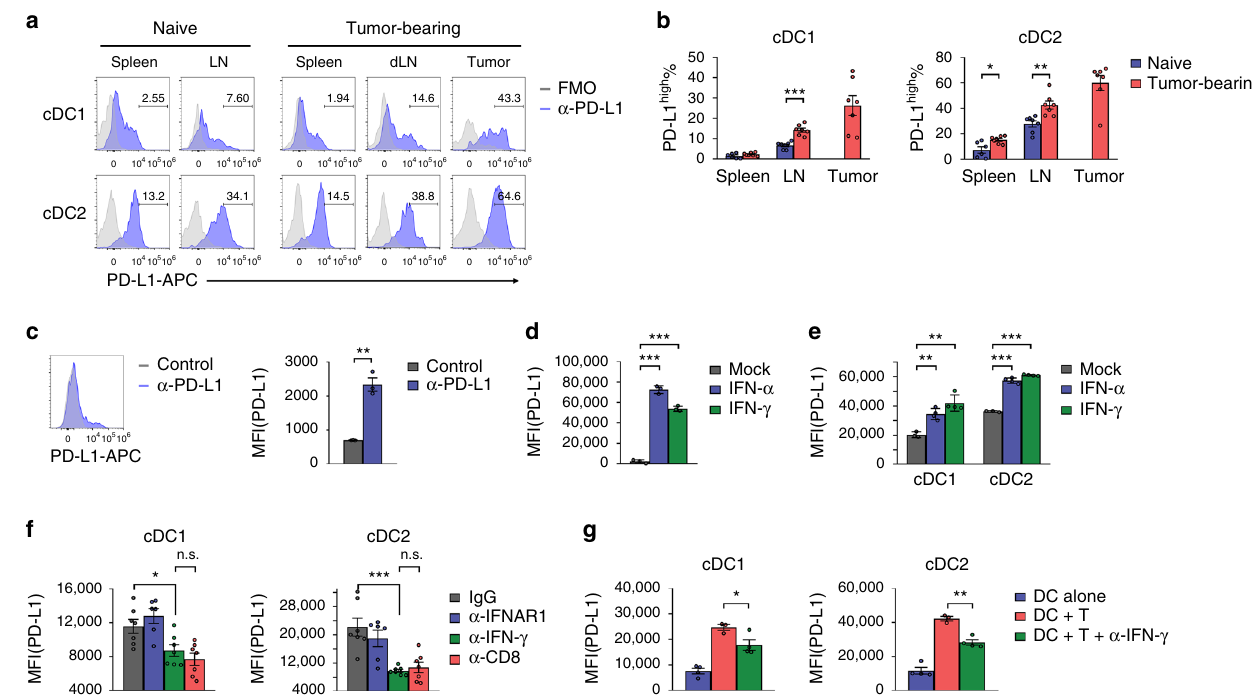
Fig. 3 PD-L1 on DCs is upregulated by IFN- γ and T cells in tumor microenvironment. a , b In naïve or MC38 tumor-bearing WT mice, PD-L1 levels on cDC1 (CD11b − CD24 + ) and cDC2 (CD11b + CD24 − ) were measured by fl ow cytometry ( n = 7, except naïve spleen n = 6). *** p < 0.0001; * p = 0.0106; ** p = 0.0030. c BMDCs were generated by FLT3-L. PD-L1 levels were measured by fl ow cytometry ( n = 3). ** p = 0.0010. d BMDCs were treated with recombinant IFN- α or IFN- γ . PD-L1 levels were measured 24 h later ( n = 3). ***p (IFN- α ) < 0.0001; ***p (IFN- γ ) < 0.0001. e Puri fi ed WT DCs were treated with IFN- α or IFN- γ . PD-L1 levels were measured 24 h later ( n = 3 mock, 4 IFN- α , 4 IFN- γ ). **p (cDC1:IFN- α ) = 0.0022; **p (cDC1:IFN- γ ) = 0.0015; ***p (cDC2:IFN- α ) < 0.0001; ***p (cDC2:IFN- γ ) < 0.0001 . f C57BL/6 mice ( n = 7 , except anti-IFNAR1 n = 6) were inoculated with 5 × 10 5 MC38-EGFP cells. Mice were treated with IgG, anti-IFNAR1, anti-IFN- γ , or anti-CD8. PD-L1 levels on cDC1 and cDC2 in tumor tissues were measured by fl ow cytometry on day 14 after